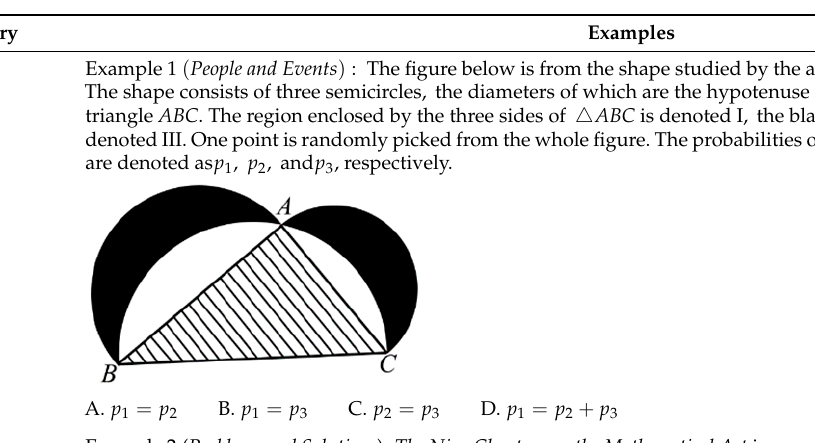
Table 2. Examples of Gaokao items with mathematical